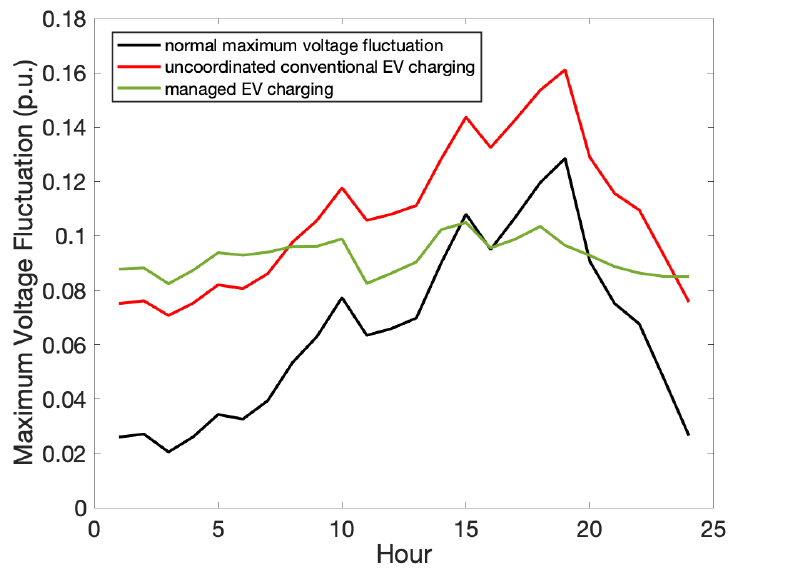
Figure 5. Comparison of maximum voltage fluctuations of different situations.